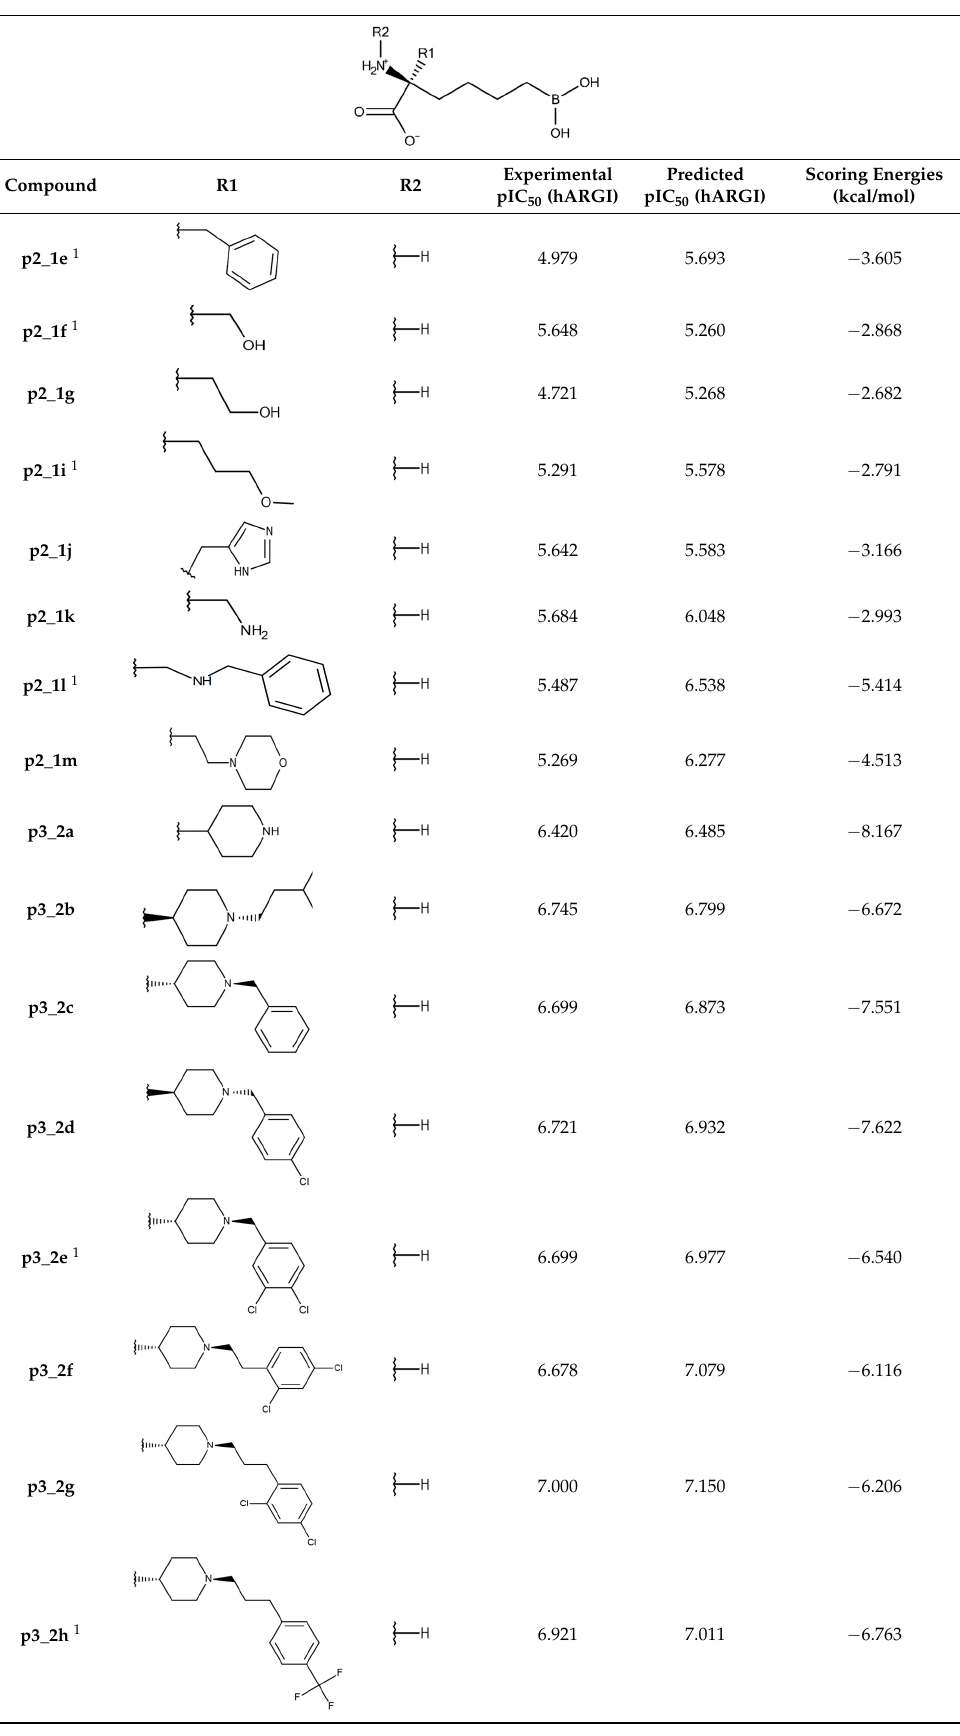
Table 1. Structures of ABH analogs as hARGI inhibitors. Experimental and predicted pIC 50 values using Model SE and docking Glide scoring energy values